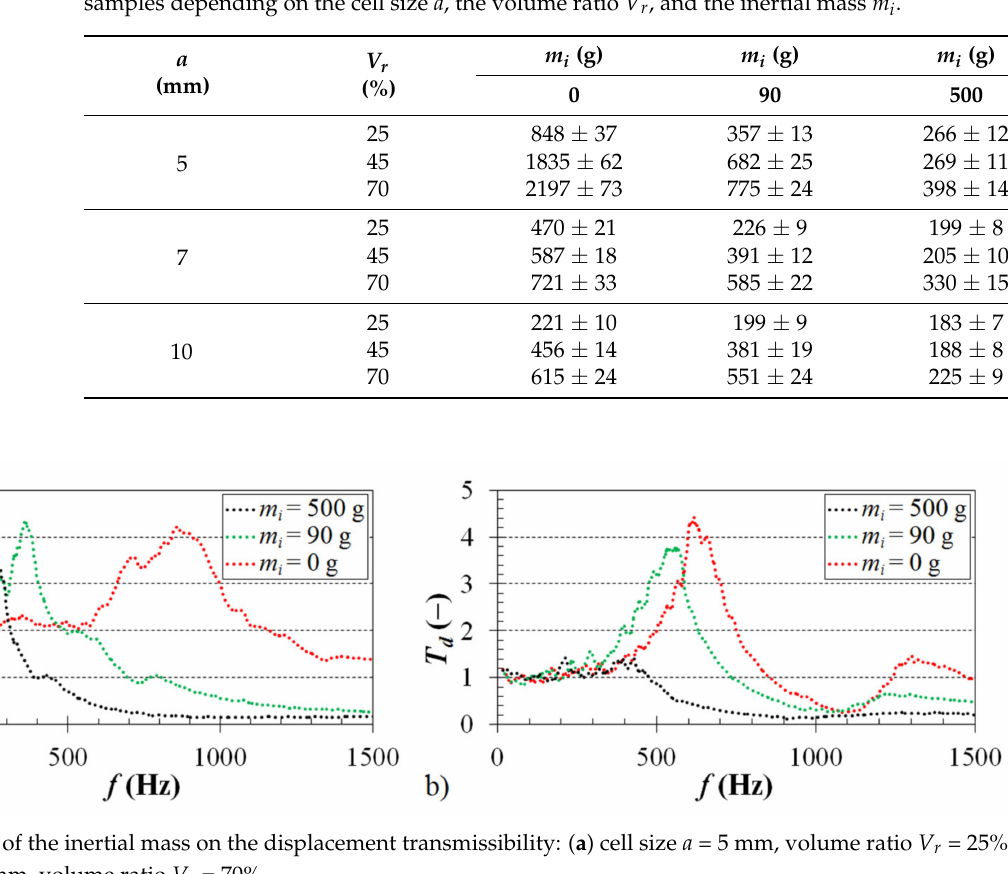
Table 2. First resonance frequencies f R 1 including their standard deviations in Hz of the tested ABS samples depending on the cell size a , the volume ratio V r , and the inertial mass m i .